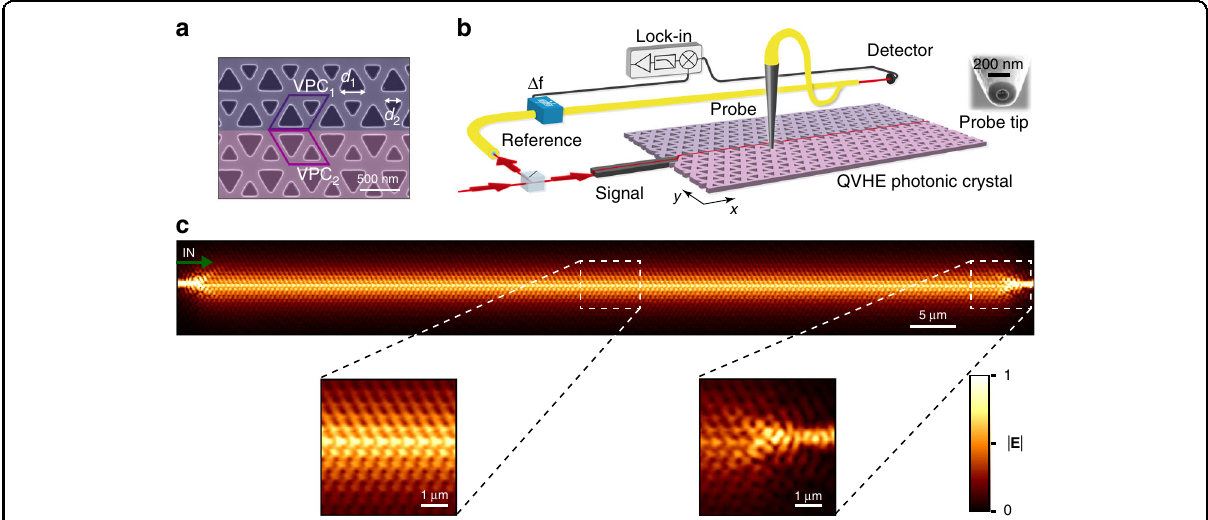
Fig. 1 Experimental visualization of a topological edge state in a valley photonic crystal. a SEM of the fabricated structure with two pseudo- colored regions depicting the two lattices VPC 1 and VPC 2 with opposite valley-Chern invariants. The unit cell with lattice constant a = 503 nm consists of equilateral triangular holes of side lengths d 1 = 0.7 a and d 2 = 0.45 a . Scale bar: 500 nm. b Schematic of the near- fi eld scanning optical microscope used to map the in-plane fi eld distribution of the topologically non-trivial PhC edge mode. To facilitate heterodyne-based phase detection, the input beam is split into two branches, labeled signal and reference. An aperture-based near- fi eld probe collects part of the evanescent tail of the in-plane fi eld components while scanning over the crystal at a height of 20 nm and couples the collected light to a single-mode optical fi ber. Inset: SEM image of the probe. c Measured normalized amplitude of the in-plane fi eld components at a laser excitation wavelength of λ = 1600 nm over the extent of 165 unit cells, with the scale bar corresponding to 5 μ m. Light is launched from a feed waveguide at the left side of the crystal, with the direction indicated by the red arrow. Left inset: zoomed-in view of the detected fi eld amplitude pattern along the domain wall. Right inset: zoomed-in view of the out-coupling fl ank of the access